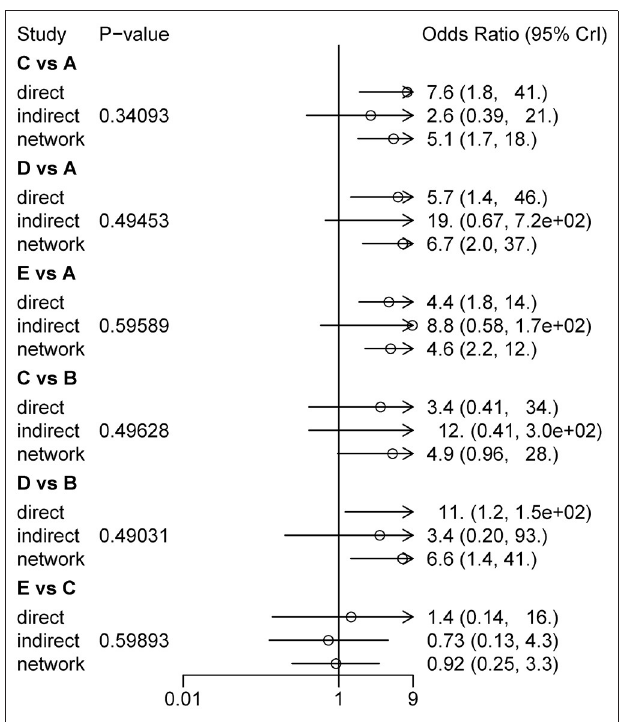
FIGURE 8 | Consistency test results assessed different treatment measures of CER (A, CT; B, CT + Drug; C, CT + MA; D, CT + EA; E, CT + MOX).